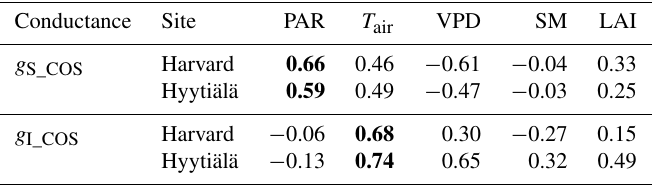
Table A2. Partial correlations linking stomatal and internal conductances to photosynthetically active radiation (PAR), air temperature ( T air ), vapour pressure deficit (VPD), soil moisture (SM), and leaf area index (LAI), computed at a half-hourly time step over the year 2012 at the Harvard Forest site and 2017 at the Hyytiälä site. For each conductance and each site, the largest partial correlation is in bold.